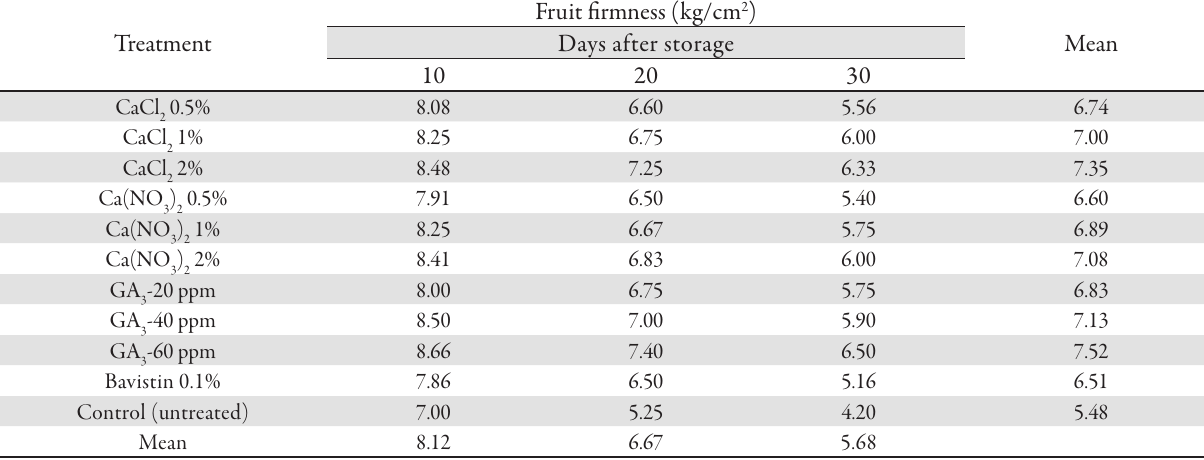
Fruit firmness (kg/cm 2